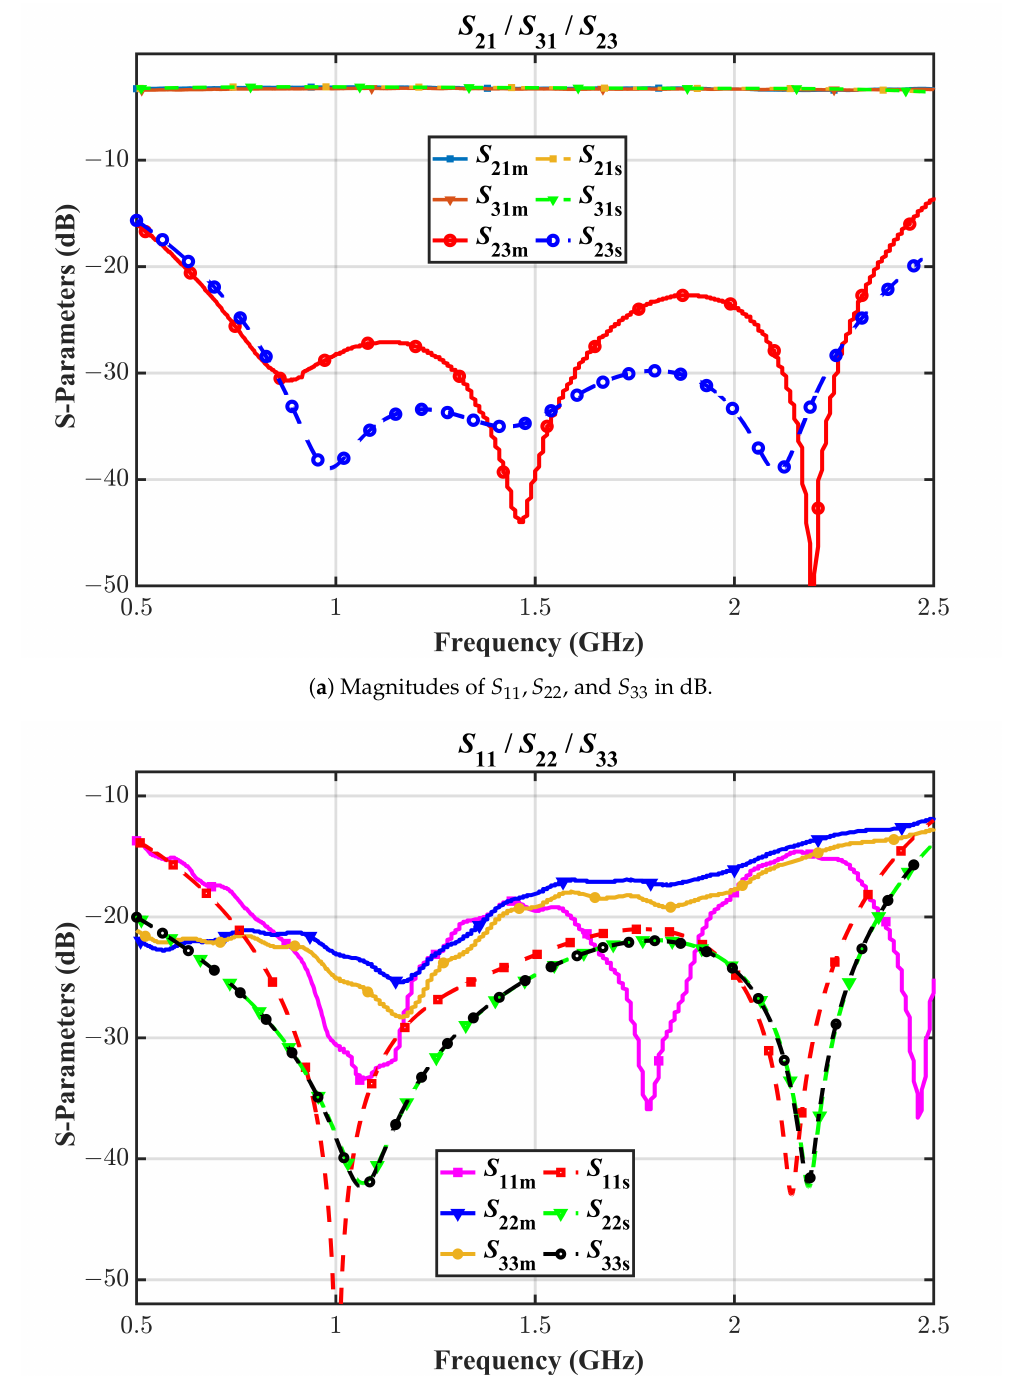
Figure 6. The simulated and the measured s-parameters in dBs. S ijm stands for measured data and S ijs stands for simulated